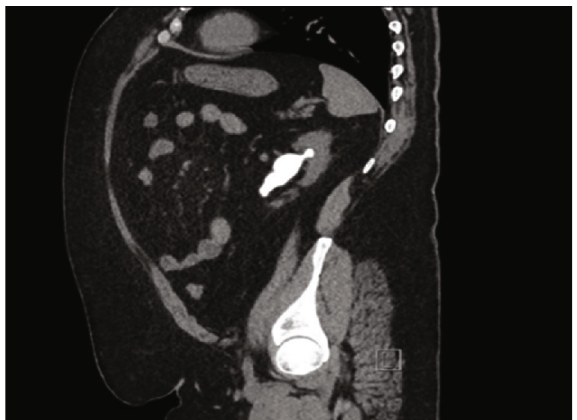
Figure 1: CT KUB demonstrating left staghorn kidney